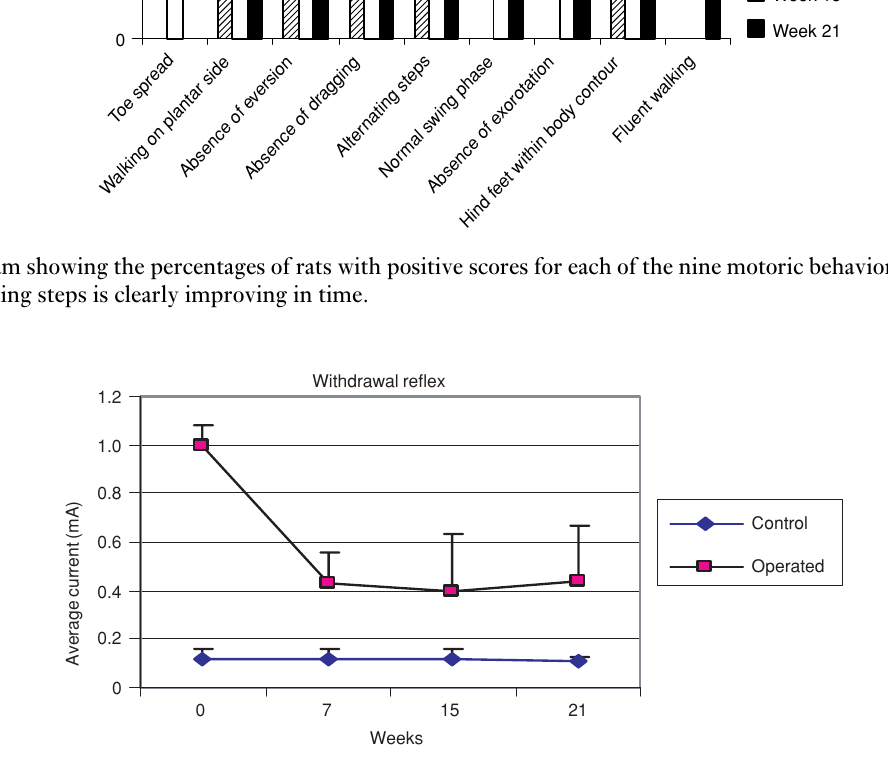
Figure 3 Graph showing the average current for a withdrawal reflex in control foot versus operated foot at time points 0, 7, 15 and 21 weeks. The average current needed for a withdrawal reflex in the operated leg did decrease quickly to approximately 0.42 mA after 7 weeks, but remained stable up to 21 weeks. Friedman two-way ANOVA revealed a significant difference for stimulus strength throughout time in the operated side because of the decrease in stimulus from day 0 to week 7 ( P < 0.05), but not for the control side ( P > 0.05). There was no interaction effect between time and stimulus strength ( P >